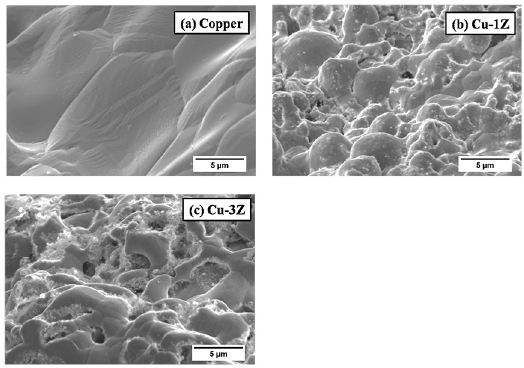
Figure 7. SEM images of transversal sections of the tapes sintered at 800 ºC: Cu, Cu-1Z, and